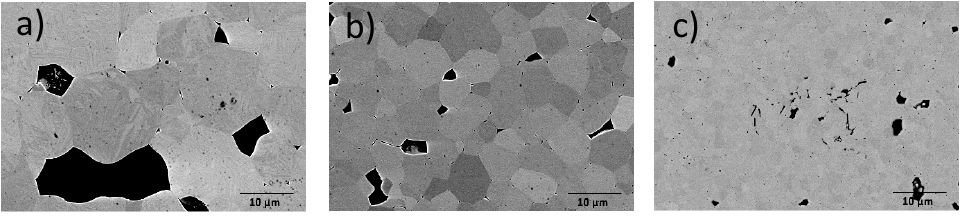
Figure 9. SEM images of co-doped samples, ( a ) 2% Fe/1.5% La; ( b ) 6.5% Fe/6% La; ( c ) 7% Fe/6% La.